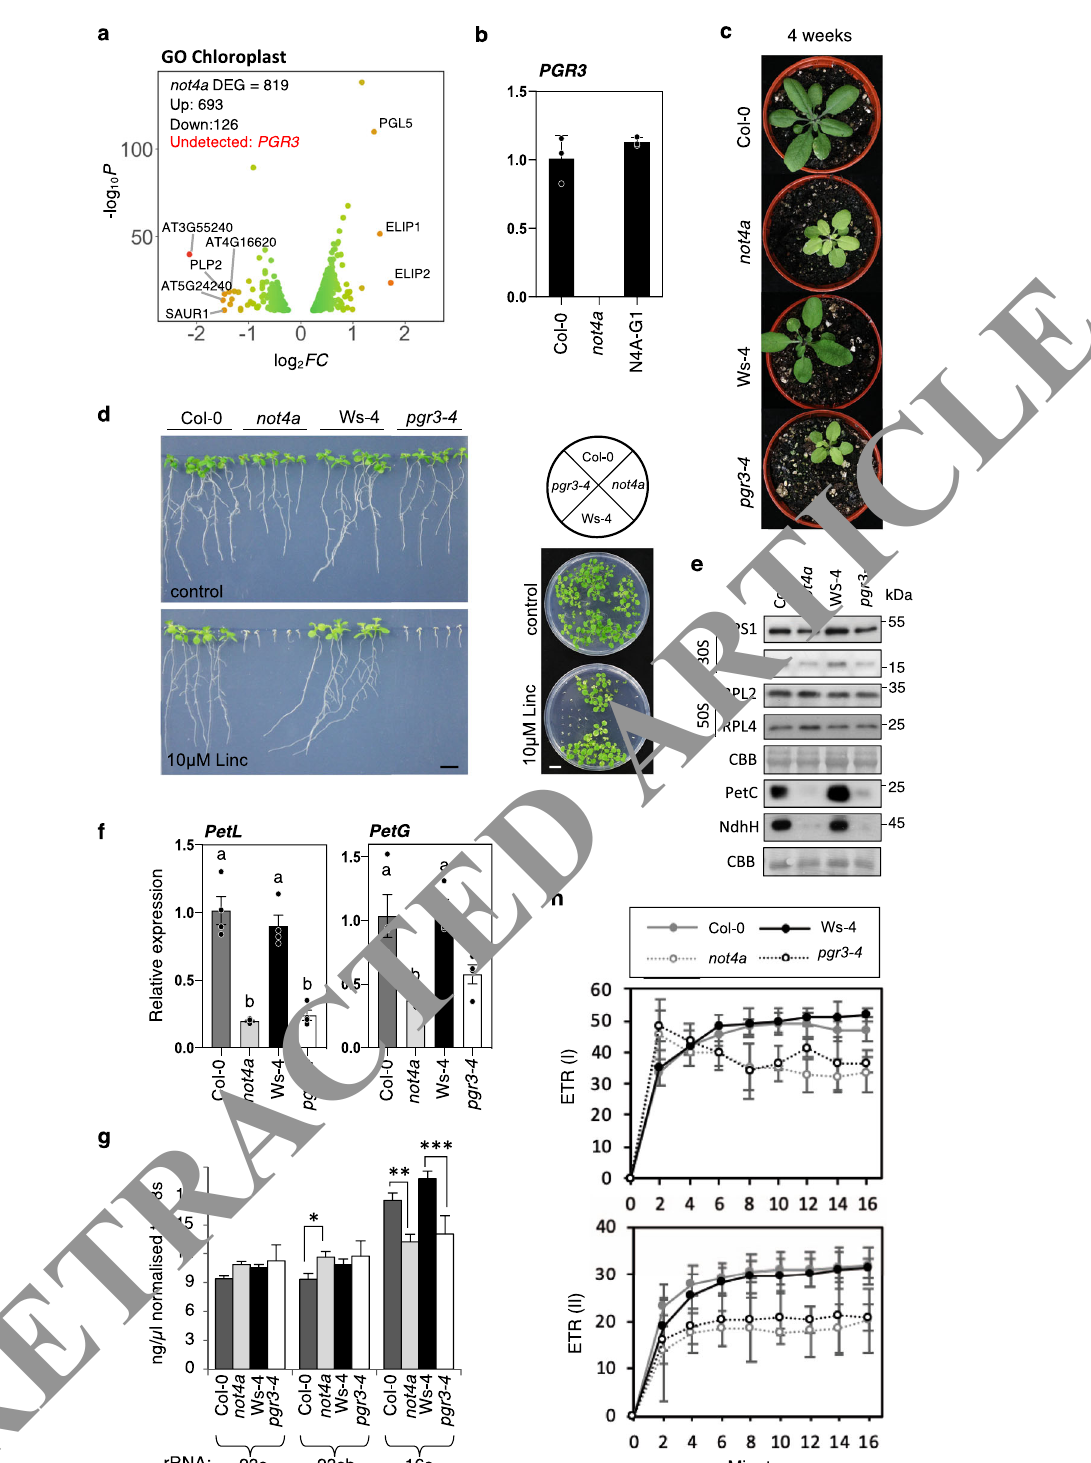
proportional pattern of expression between lines (Fig. 7a, b and Supplementary Fig. 7B). When compared to their untransformed backgrounds, two of the three Col-0 (lines 1 and 2) and all not4a lines, possessed higher transcript levels than attributable to the doubled PGR3 gene copy number present in homozygous transgenics, suggesting a decoupling from endogenous negative regulation (Fig. 7b). PGR3-YFP localized as expected within chloroplasts in both backgrounds (Fig. 7c and Supplementary Fig. 7D). Given that